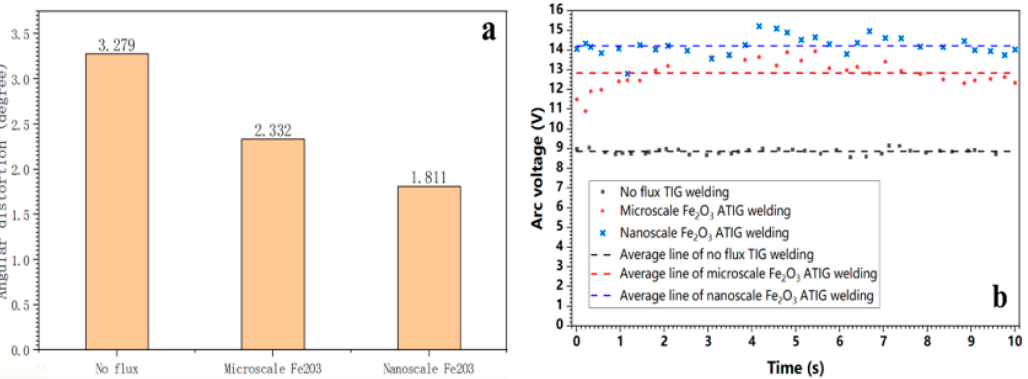
Figure 7. Effect of activated flux on angular distortion of the weldment ( a ) and welding arc voltage ( b ).